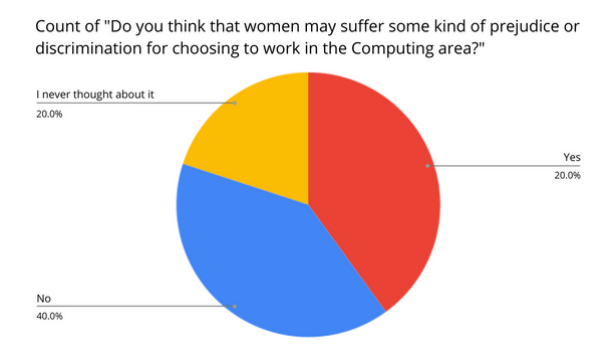
Figure 7. Graph of the responses from the Computational Thinking workshop to the question “Do you think that women may suffer some kind of prejudice or discrimination for choosing to work in the Computing